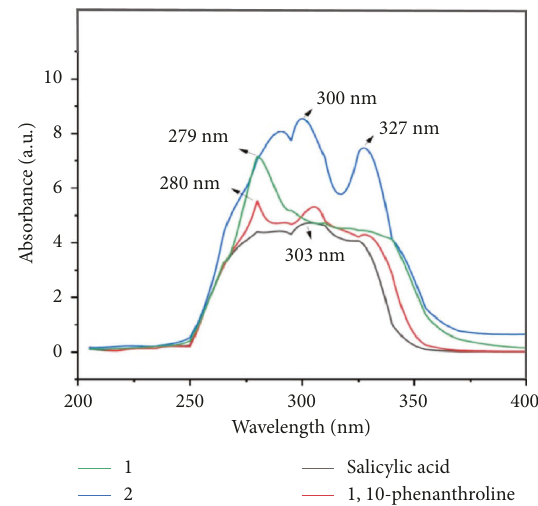
Figure 2: UV-visible absorption spectra of salicylic acid, 1,10- phenanthroline. Complex (1) and (2).